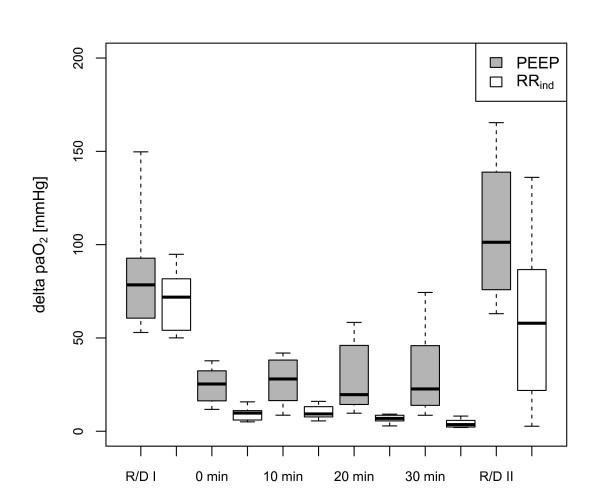
Time chart of the Δ paO2. Δ paO2 (mmHg) after induction (R/D I), within 30 minutes of intervention and after re-induction (R/D II): no respiratory-dependent Δ paO2 was founded before provocation. A significantly higher Δ paO2 persists following PEEP intervention (padjusted < 0.001 after Bonferroni correction). In four animals of the RRind group no Δ paO2 with an amplitude ≥ 50 mmHg was inducible in R/D II due to fixed atelectasis.